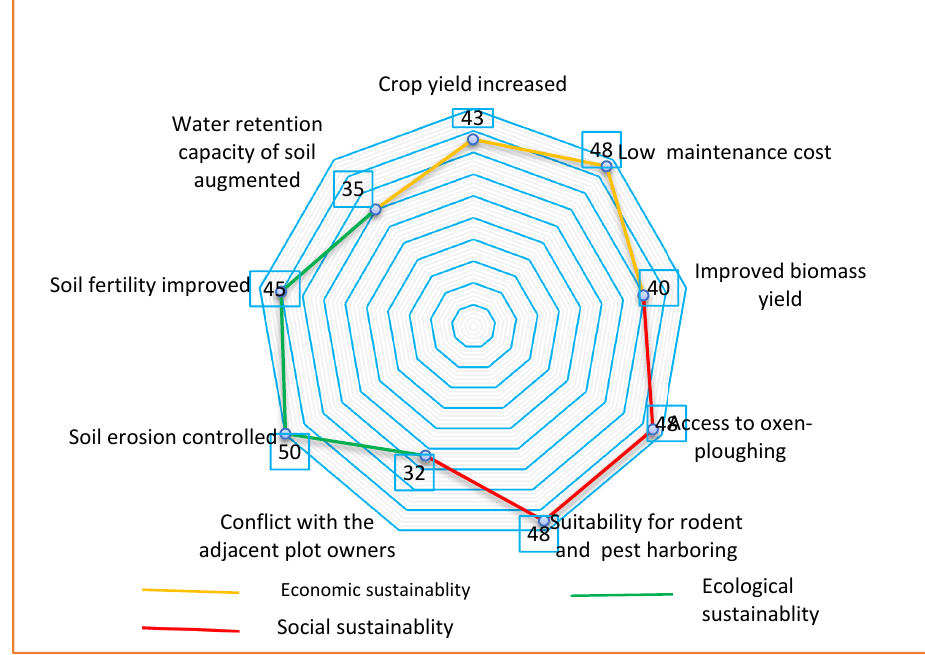
Figure 7. Sustainability of mixed